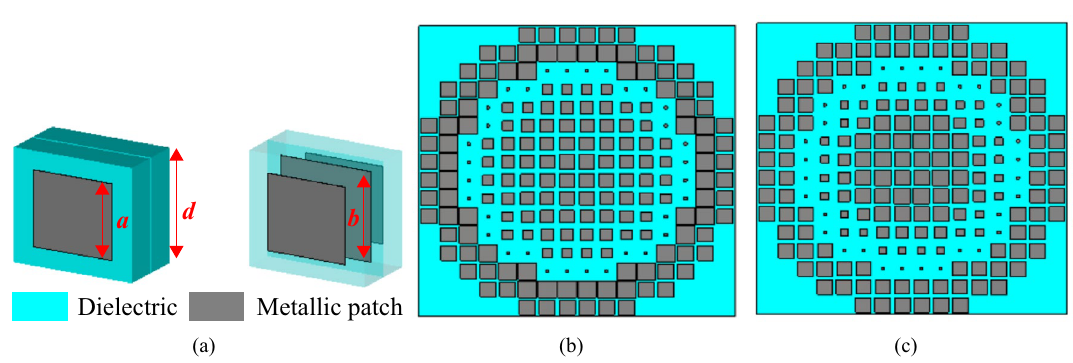
Figure 6. ( a ) Perspective view of the printed unit-cell configuration, and Layouts of the printed metasurface: ( b ) patches on the top layer (bottom layer is identical); ( c ) patches on the middle